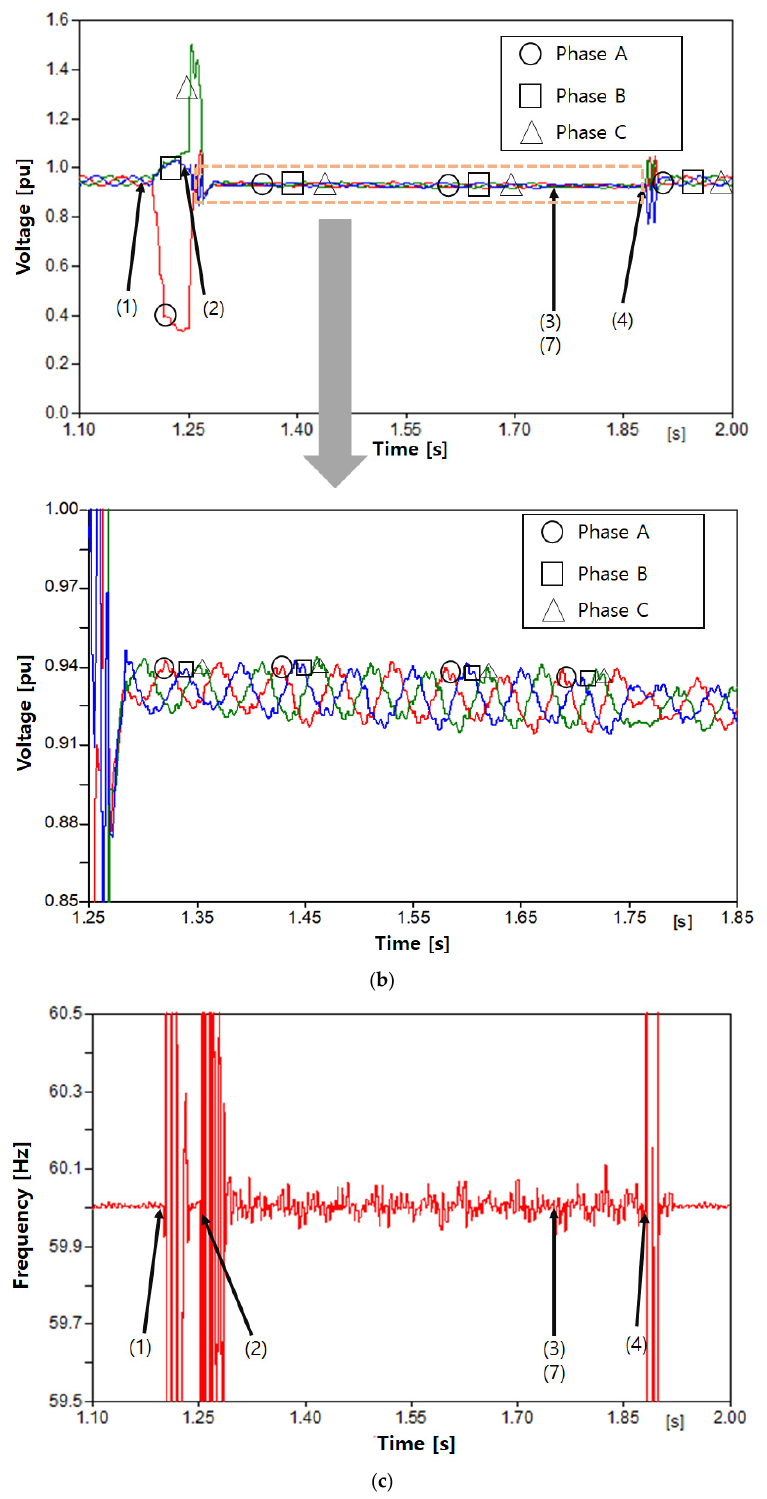
Figure 8. Simulation results of Case 1: ( a ) current flowing to Load 2; ( b ) voltage at Bus 3; ( c ) frequency at Bus 3.